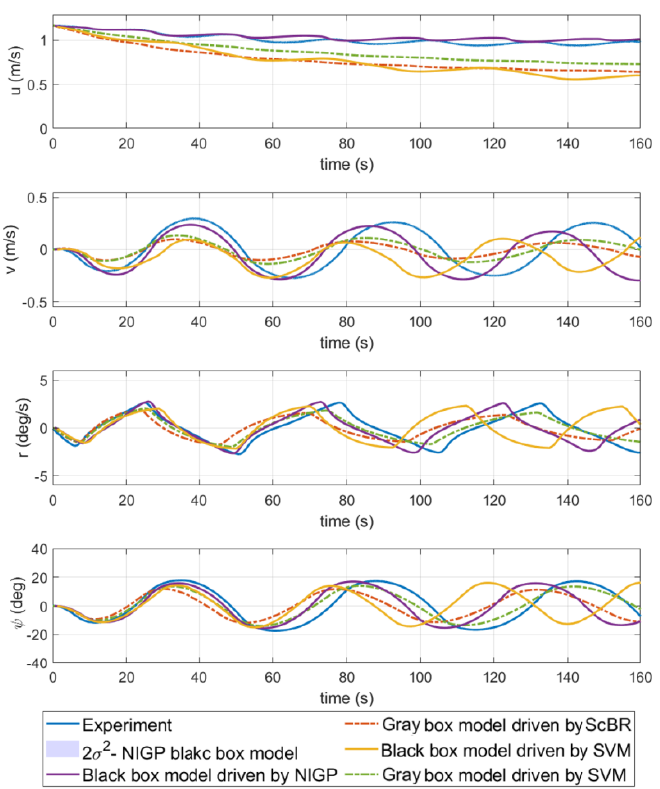
Figure 6. Comparisons of results of the ship predicted motion; the 15°/5° zigzag test. Table 4. Estimation of forecast accuracy by RMSE and computation time for the validation test. Parametric Gray-Box Model